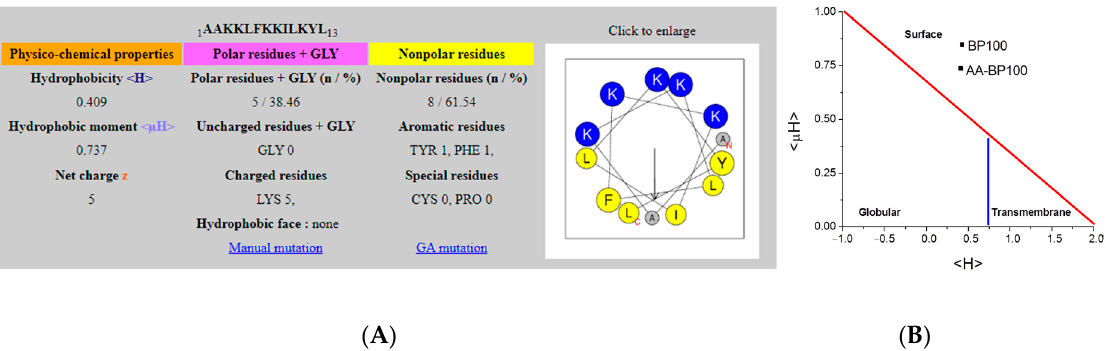
Figure 10. ( A ) NAPHT-BP100 peptide sequence and formed α -helix properties calculated using Heliquest [54]. ( B ) BP100 and NAPHT-BP100 α -helices properties placed in the Eisenberg plot.